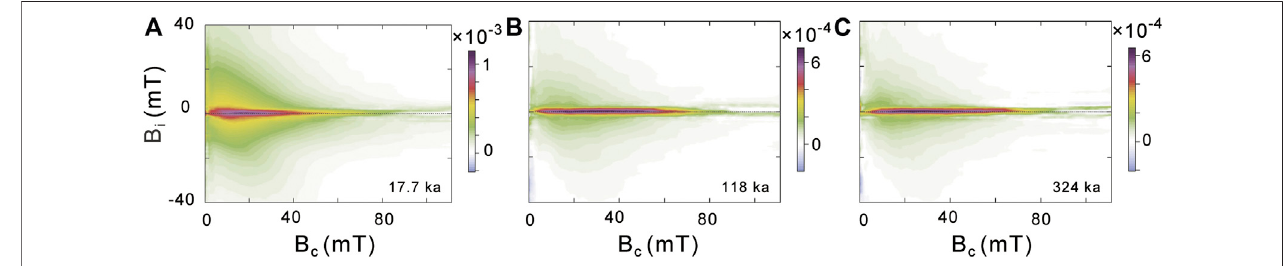
FIGURE 4 | The First-order reversal curve (FORC) diagrams of three studied samples at 17.7 ka (MIS 2) (A) , 118 ka (MIS 5e) (B) , and 324 ka (MIS 9) (C) , respectively. All samples show a clear “ central-ridge ” behavior. B i , magnetostatic interaction fi eld; B c , coercive fi eld.